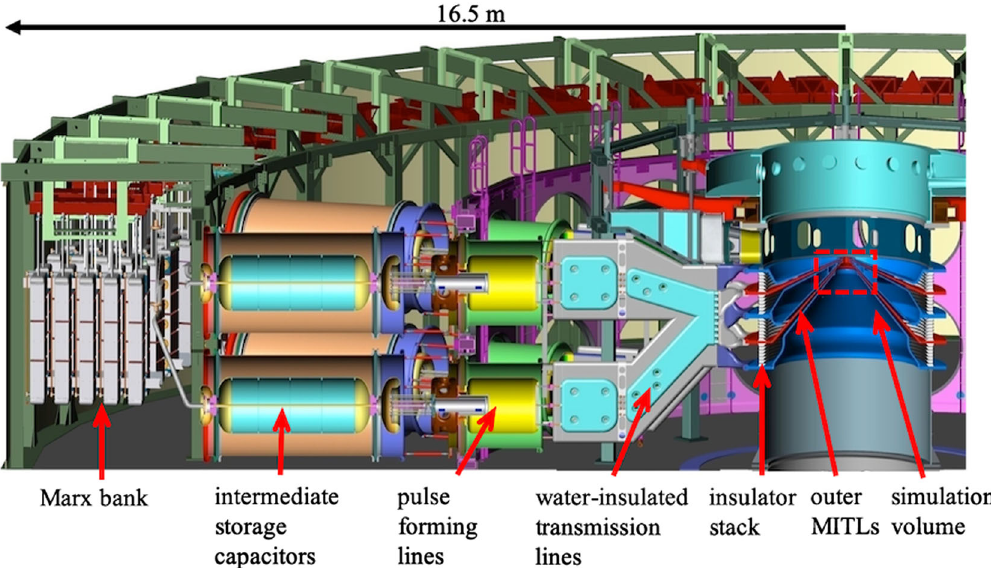
FIG. 1. Cross section of Sandia ’ s Z machine [3,4]. The electrical characteristics of the components shown are represented in PIC simulations by transmission-line-circuit model elements. The 3D simulation volume is outlined by the dashed red lines. The arrows indicating the insulator stack and outer MITLs point to the location of anode B-dot probes for those